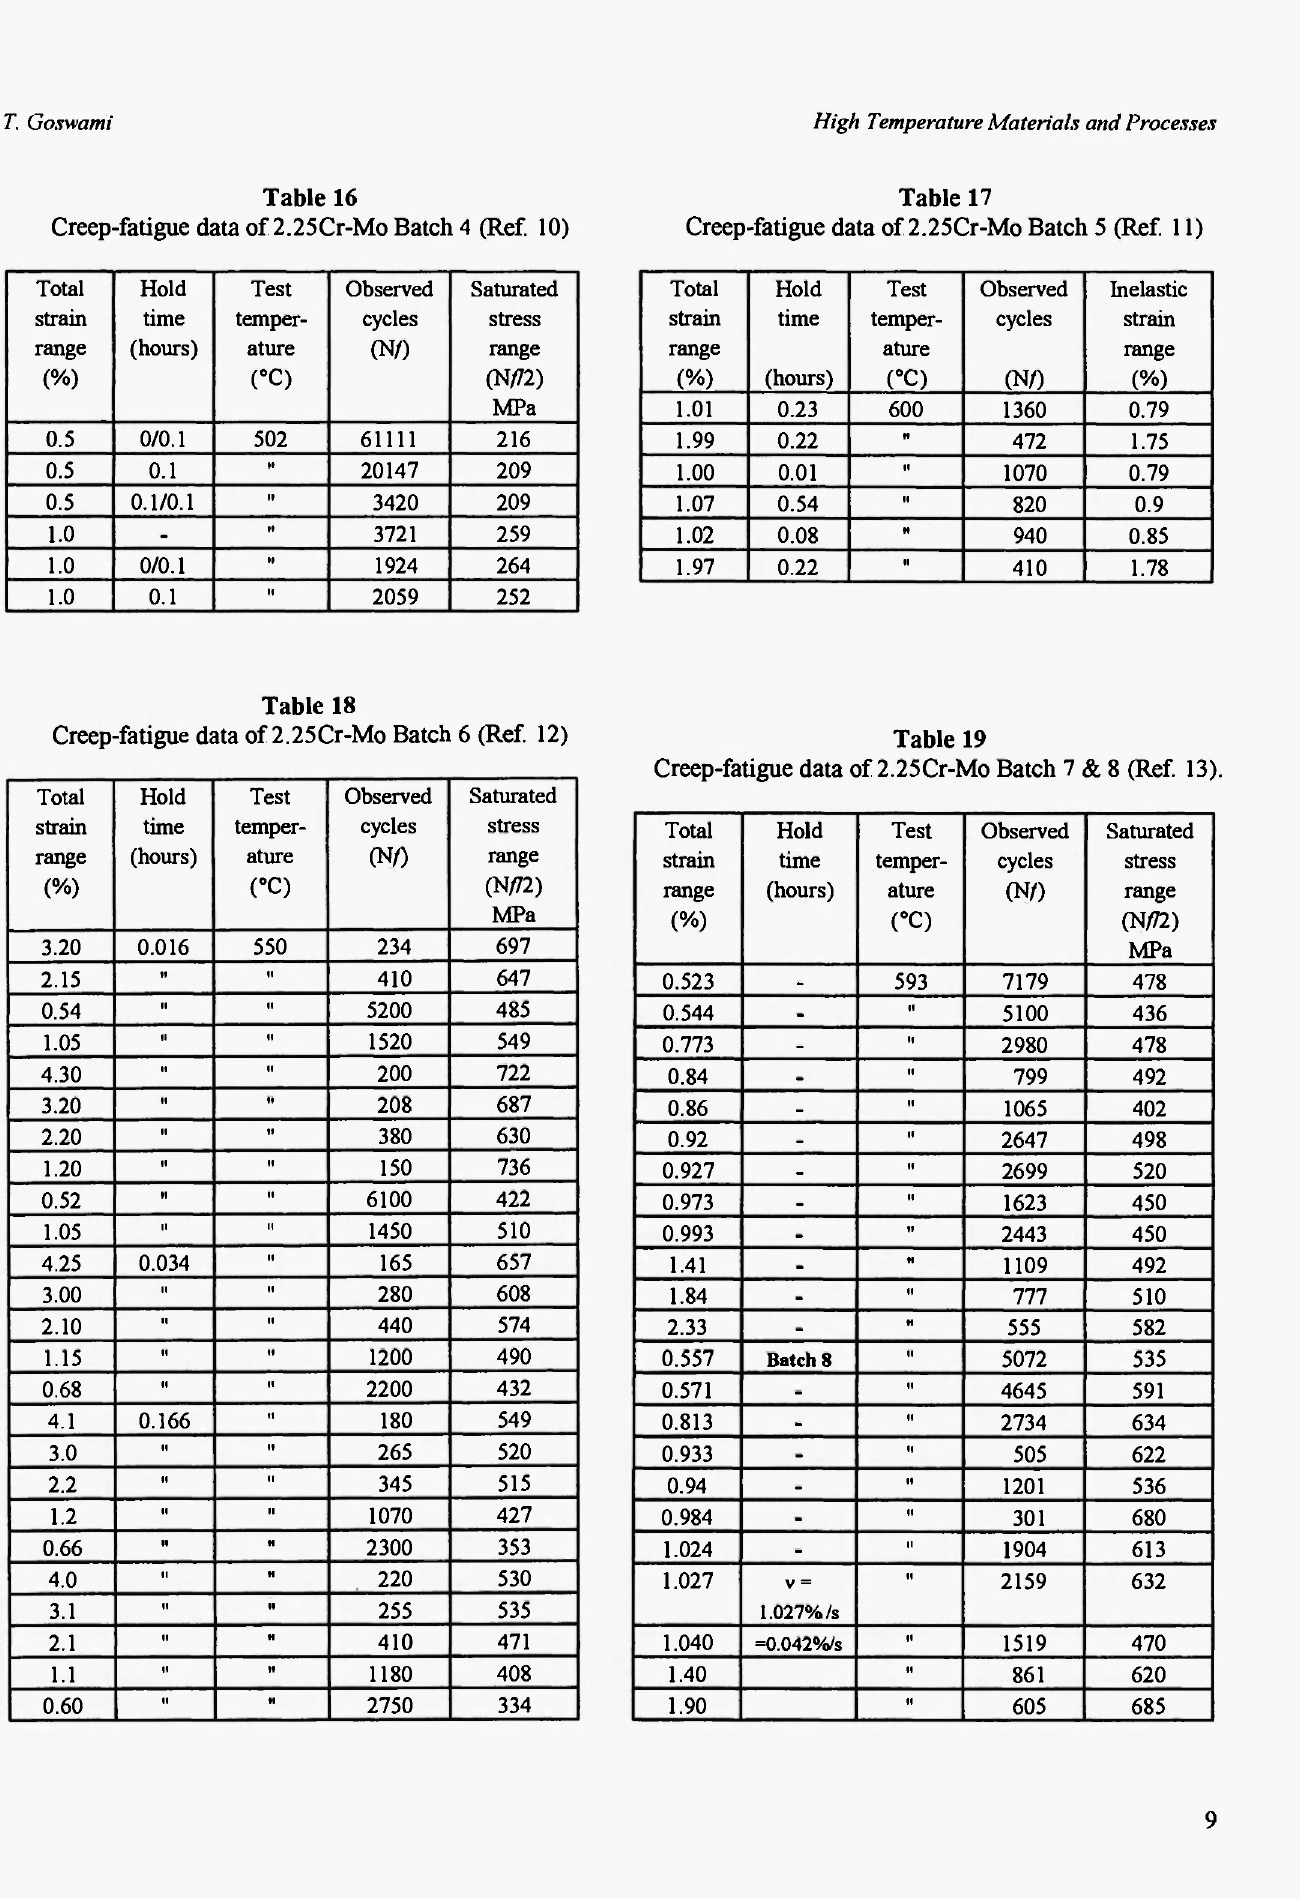
Creep-fatigue data of 2.25Cr-Mo Batch 6 (Ref. 12)